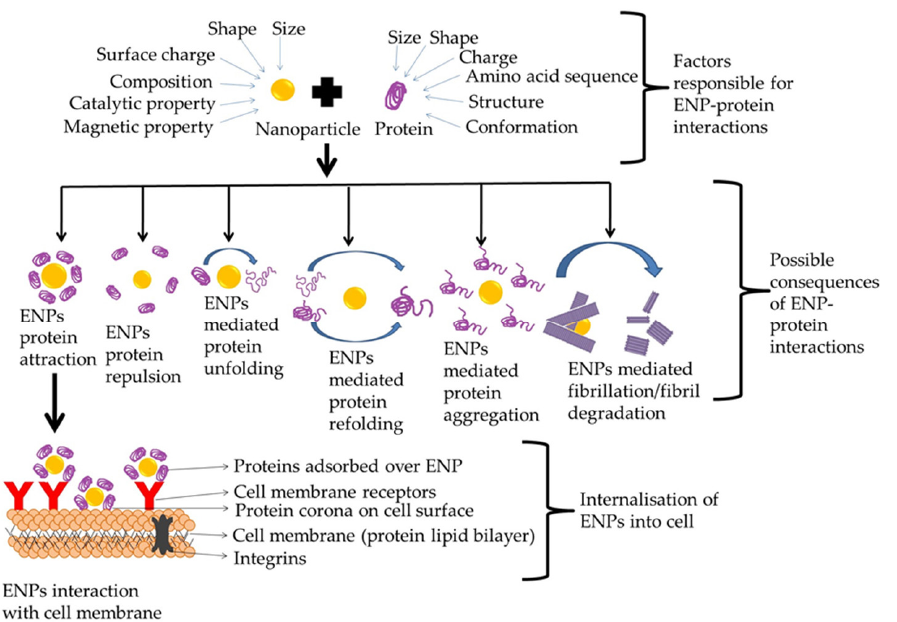
Figure 2. Factors governing ENP-protein interactions and the subsequent effect of these interactions on the protein conformation and function. ENP-protein interaction results in attraction between ENPs and proteins having opposite charges and repulsion between like charges. As proteins are among the first molecules with which ENPs interact after their entry inside the biological systems, therefore, this interaction facilitates passage through the semi-permeable plasma membrane of the cells. Further, these ENPs may modulate protein folding processes such as unfolding, refolding, misfolding, aggregation and